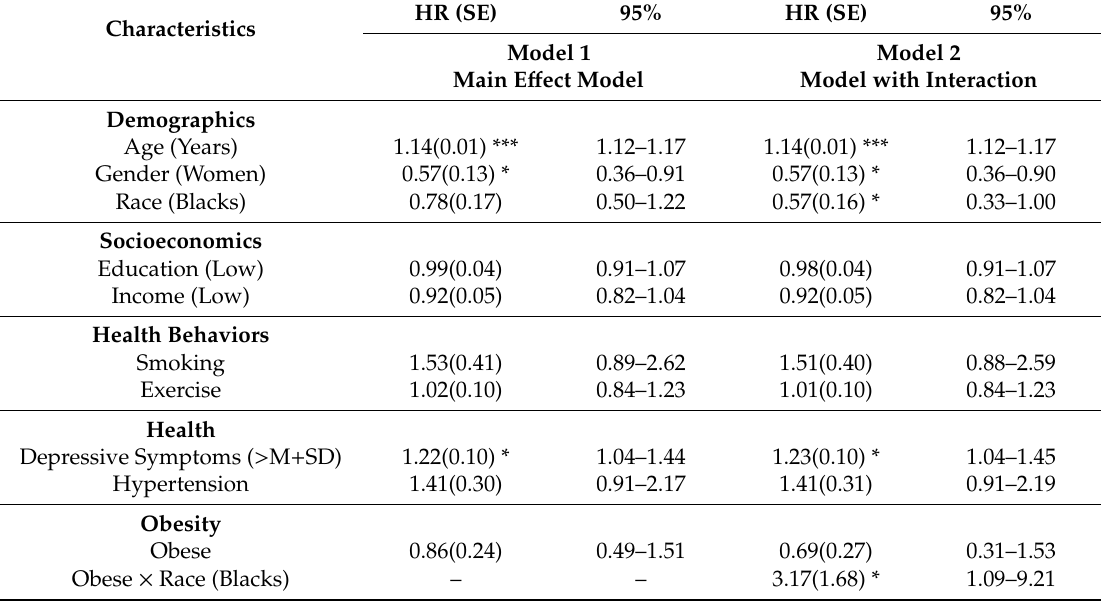
Table 3. Pooled sample Cox proportional hazards models with time of death due to cerebrovascular disease as the outcome ( n = 3361).